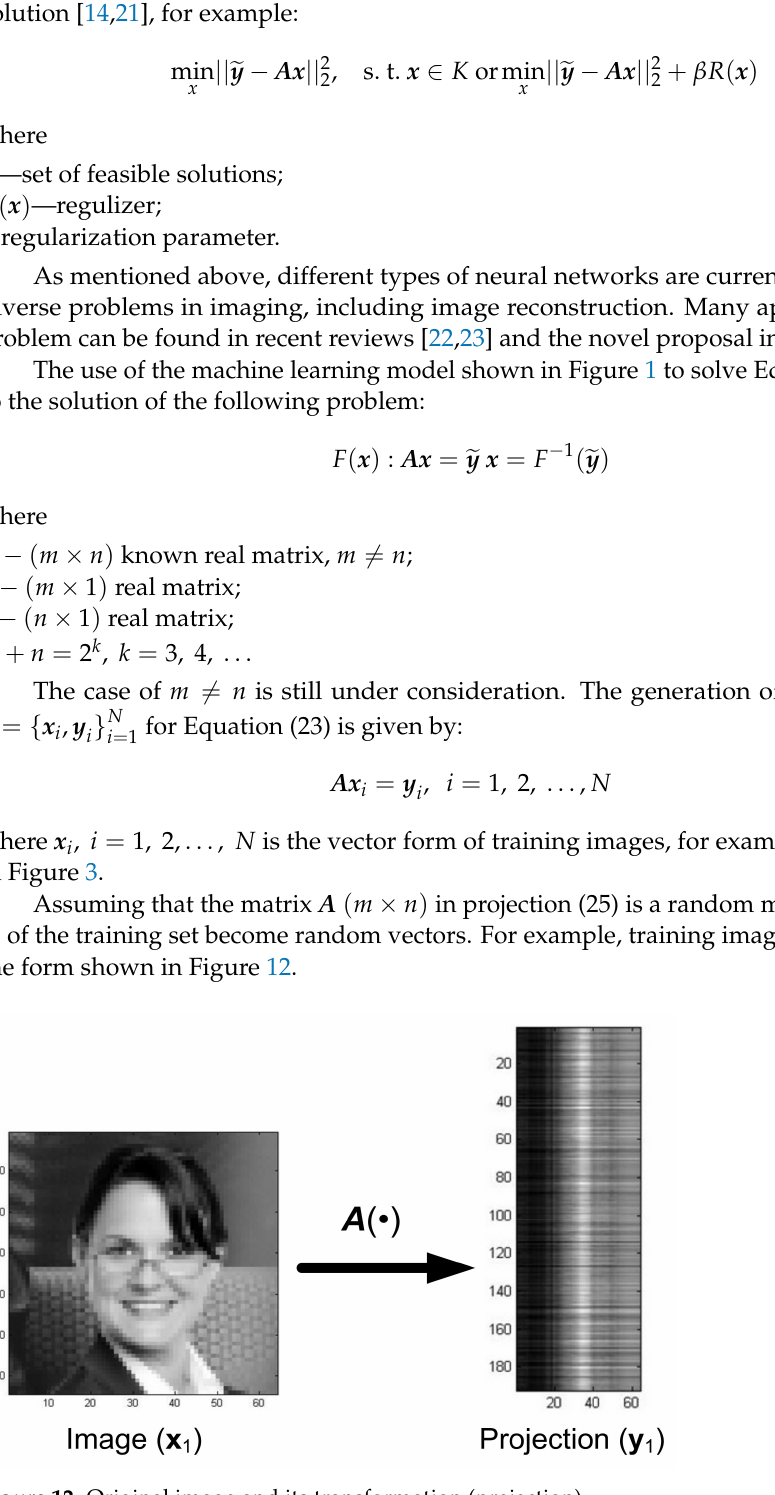
Figure 12. Original image and its transformation